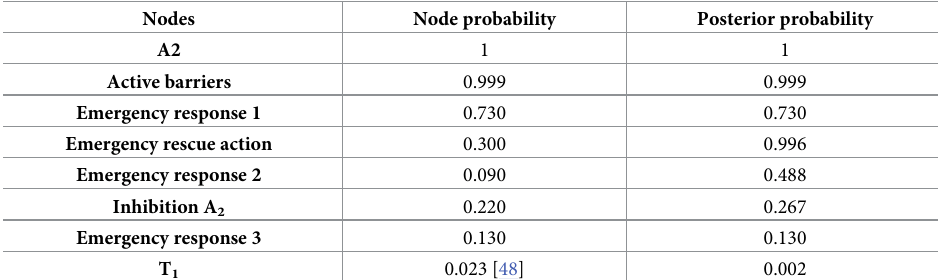
Table 23. Probability value of each node in the BN.